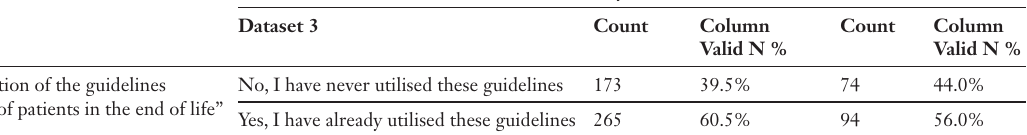
Utilisation of the guidelines “Care of patients in the end of life”.